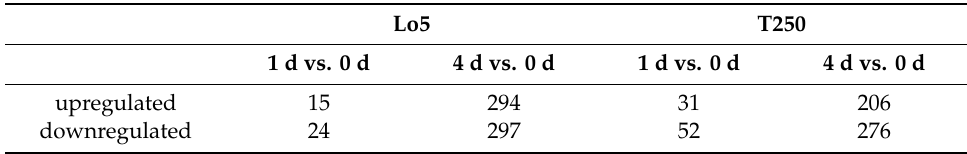
Table 1. Number of up- and downregulated transcripts identified in response to the growth without N for root tissues of Lo5 and T250 inbred lines ( p -value ≤ 0.01 and | Log 2 (ratio) | ≥